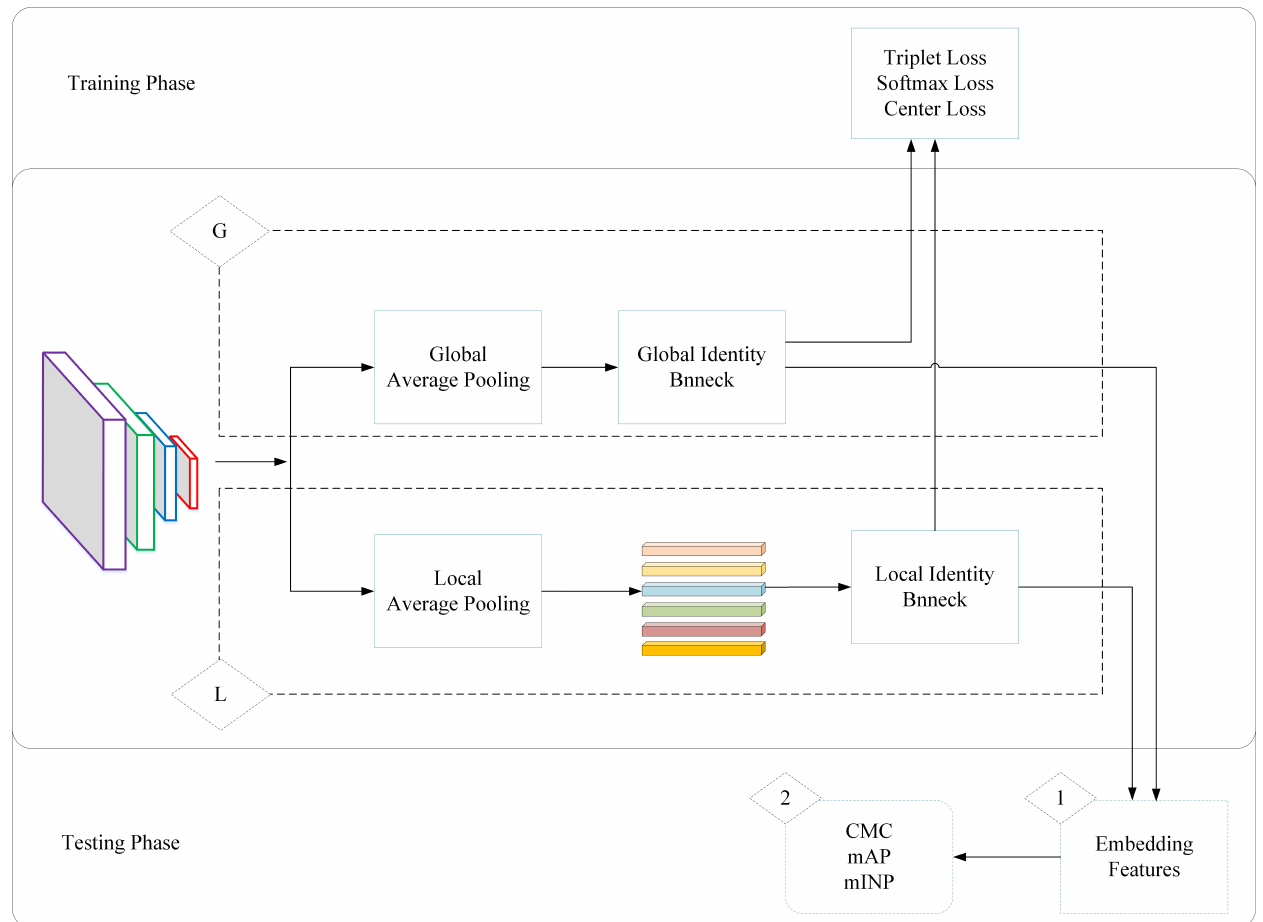
Figure 3. Global and local branch network, which is a multi-level feature-fusion network. It is a pedestrian re-recognition network framework without attribute recognition. After local average pooling, six different part features are generated, represented by different colors in this